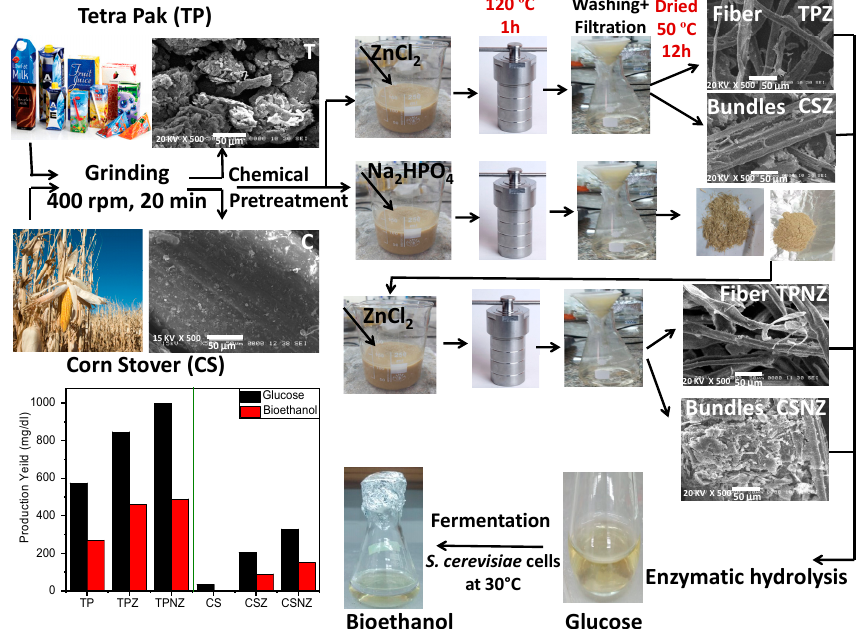
Figure 1. Schematic description of the pretreatment steps for Tetra Pak (TP) and Corn Stover (CS) to produce Tetra Pak and corn stover treated by ZnCl 2 (TPZ) and (CSZ), and Tetra Pak and Corn Stover treated by Na 2 HPO 4 then ZnCl 2 (TPNZ) and (CSNZ) respectively, for enzymatic hydrolysis and subsequently for bioethanol production.